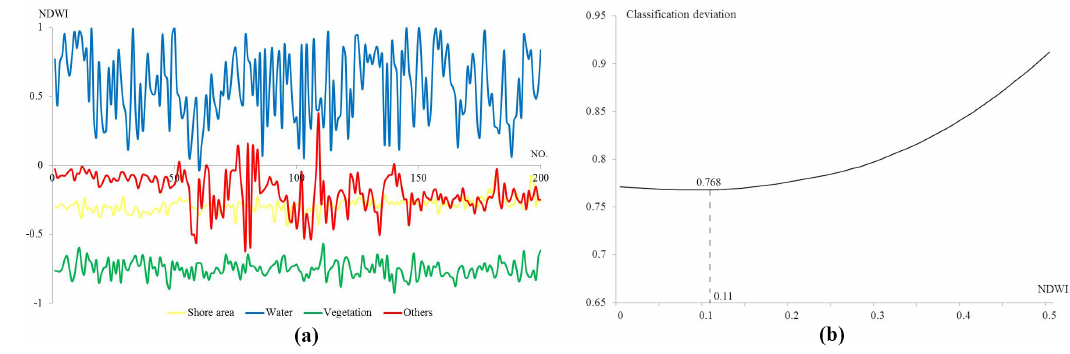
Figure 3. Determination of T w . ( a ) NDWI line of each category. ( b ) Deviation trend with the NDWI value changing from 0 to 0.5.